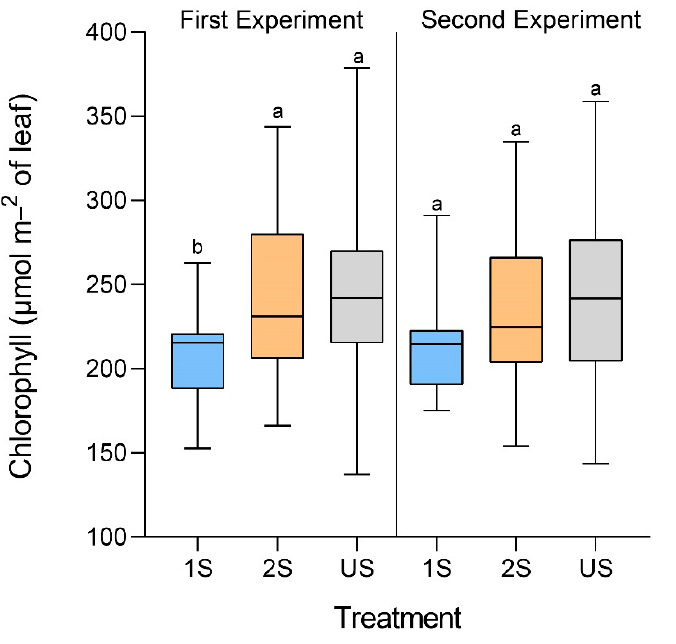
Figure 5. Box-and-whisker plots of the chlorophyll contents of primed (2S) and unprimed (1S) soybean C08 plants under drought treatment compared to the unstressed control (US). The whiskers represent the maximum and minimum values in the sample. Wilcoxon rank-sum test following one-way ANOVA was used to compare between the mean values of each treatment. Different letters indicate significant differences between groups at p < 0.05. n = 19–30.